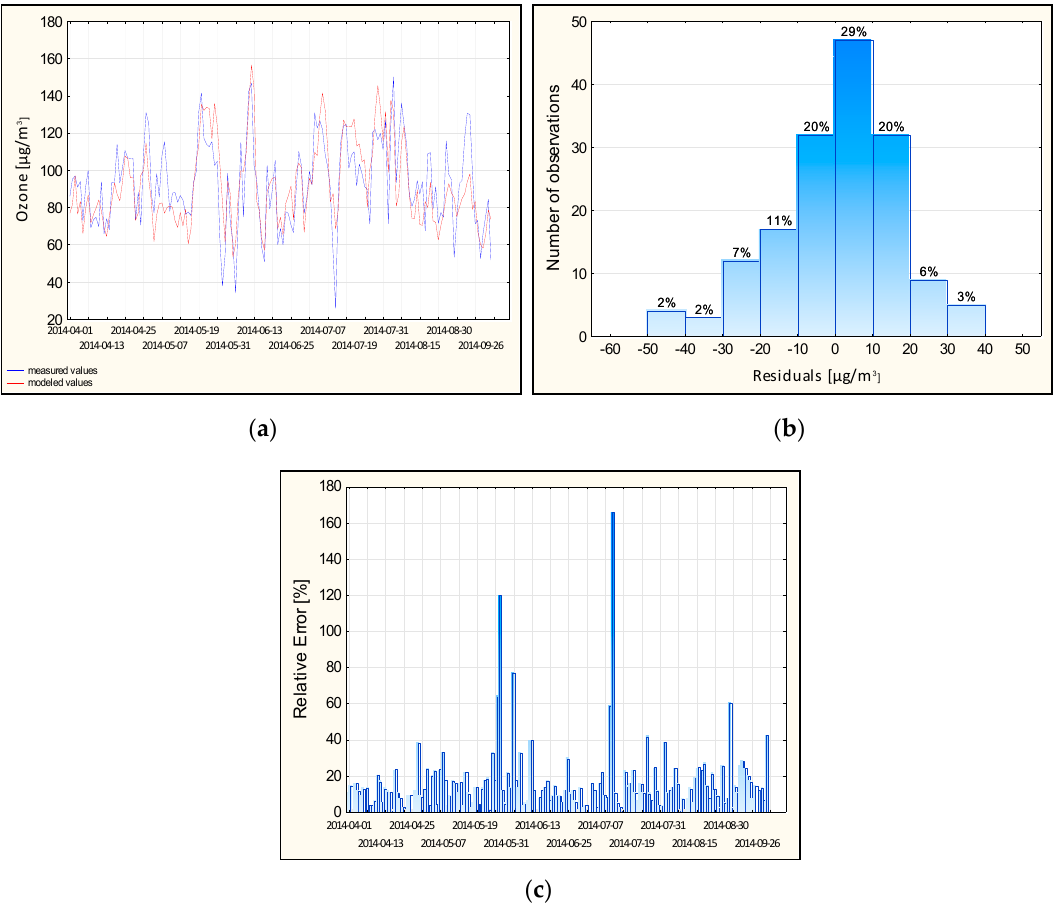
Figure 5. Results of modeling the daily maximum surface ozone concentration from April to September 2014 (Warsaw station). ( a ) Graph of the course of measured and modeled surface ozone concentration values, ( b ) histogram of residual values, and ( c ) graph of the relative errors. Table 6. Statistical performance of the neural network models for data set from 2014. maximum observed and predicted concentration ( µ g/m 3 ), respectively; So and Sa—standard deviation of observed and predicted concentration ( µ g/m 3 ), respectively; R 2 —coefficient of